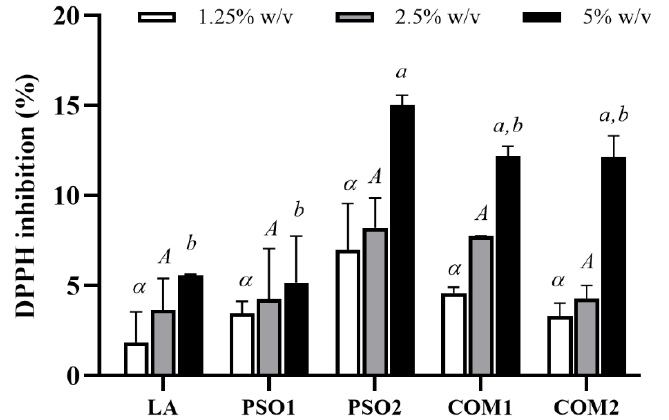
Figure 1. DPPH • inhibitory effect of pumpkin seed oil samples (PSO1, PSO2, COM1, COM2) and linoleic acid (LA). Data obtained from triplicate and three independent experiments are expressed as mean ± SD. The symbol, α , presents no significant difference among samples at the concentration of 1.25% w / v . The capital letter, A , presents no significant difference among samples at the concentration of 2.5% w / v . The letters, a and b , present significant differences among samples at the concentration of 5% w / v , p < 0.05.